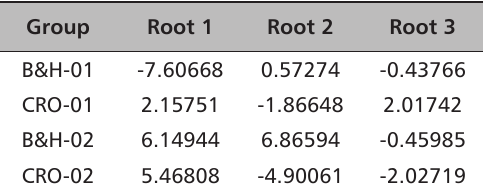
taBle 7. Means of canonical